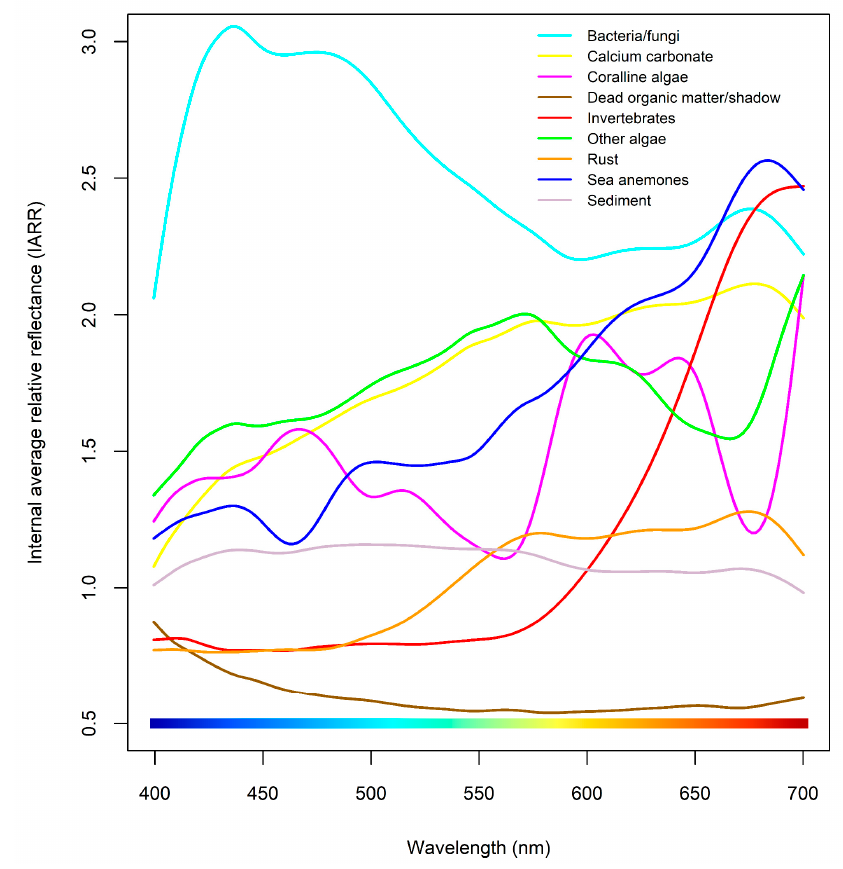
Figure 2. Mean internal average relative reflectance (IARR) signatures of the nine spectral classes identified in the underwater hyperspectral imaging (UHI) transect from the Figaro wreck site. The mean values were calculated based on the training pixels shown in the third column of Table 1.